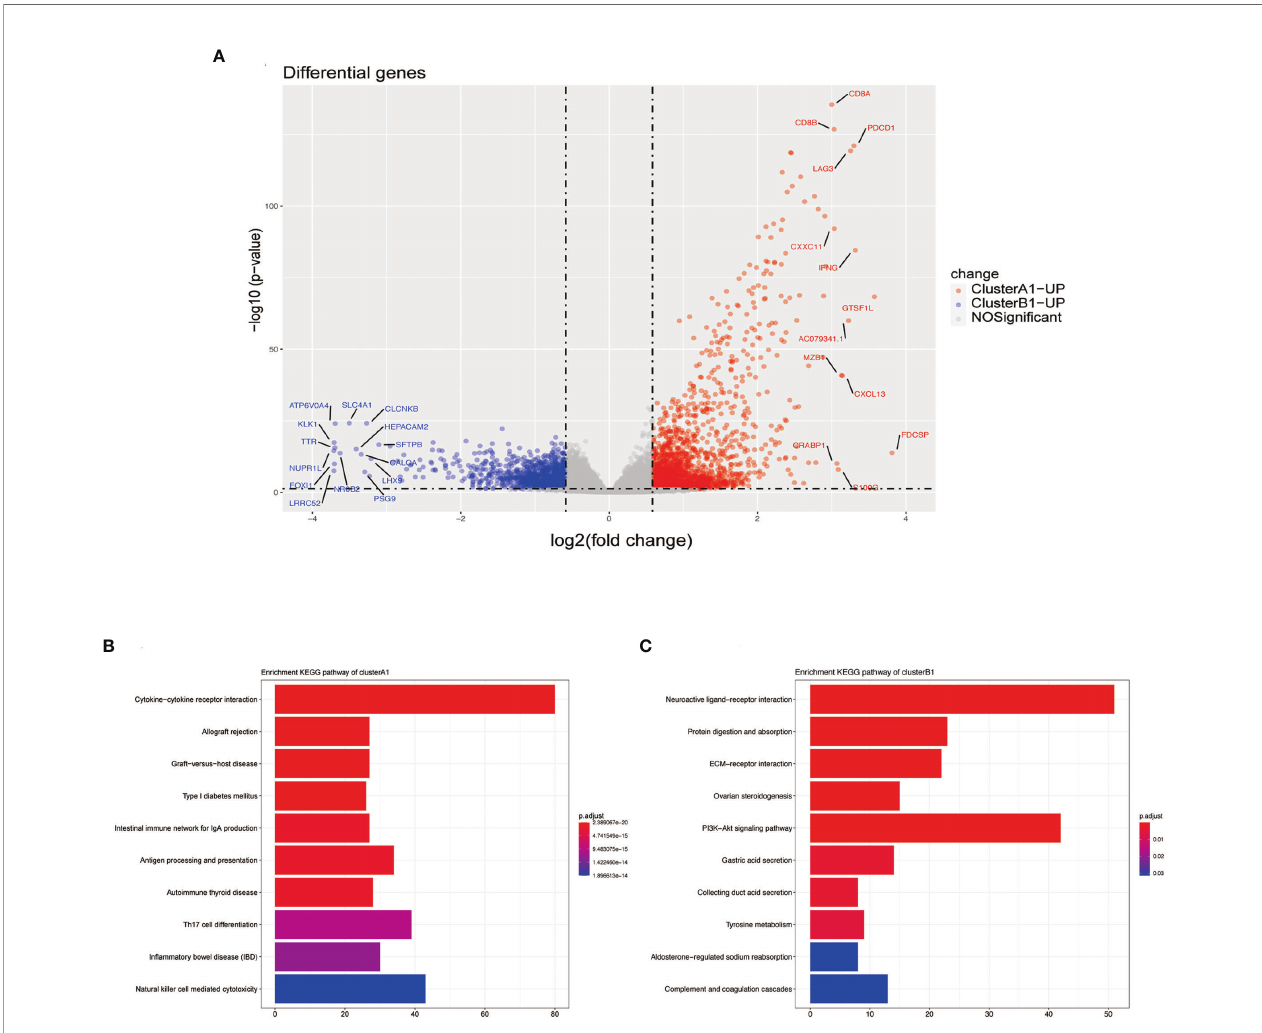
FIGURE 5 | (A) Volcano plots DGEs. (B) Barplot of upregulated genes in cluster A1 by using the KEGG pathway enrichment analysis of DEGs. (C) Barplot of upregulated genes in cluster B1 by the using KEGG pathway enrichment analysis of